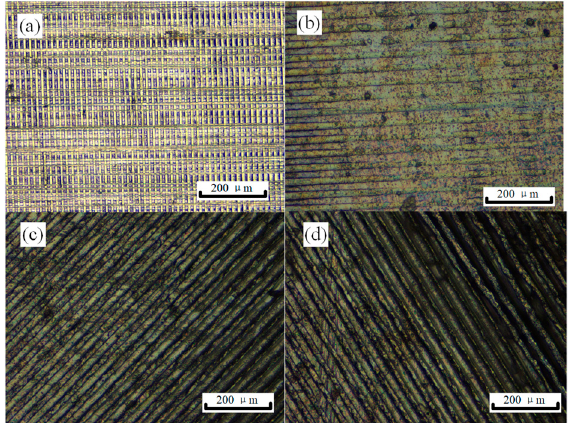
Figure 6. Micrographs of the micro-channel patterns obtained by EA micro-embossing at different current densities: ( a ) 0 A/mm 2 , ( b ) 6 A/mm 2 , ( c ) 10 A/mm 2 , ( d ) 13 A/mm 2 .